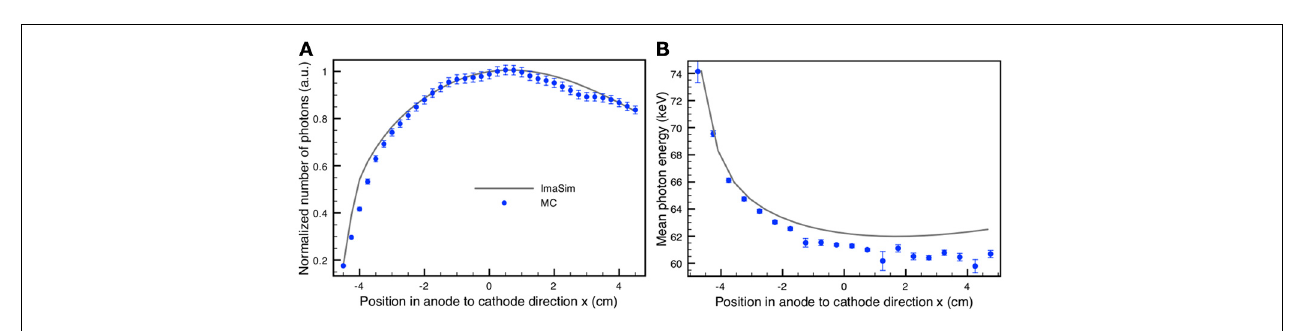
central mean photon energy profiles along the cathode anode direction produced by Monte Carlo simulation (circles) and ImaSim (solid